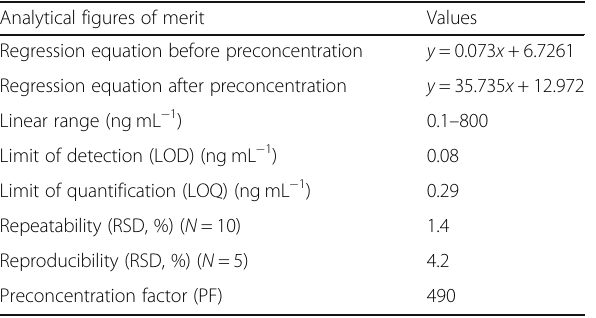
Table 3 Analytical figures of merit of the applied UA-DSPME/ HPLC-DAD method for preconcentration of CBZ